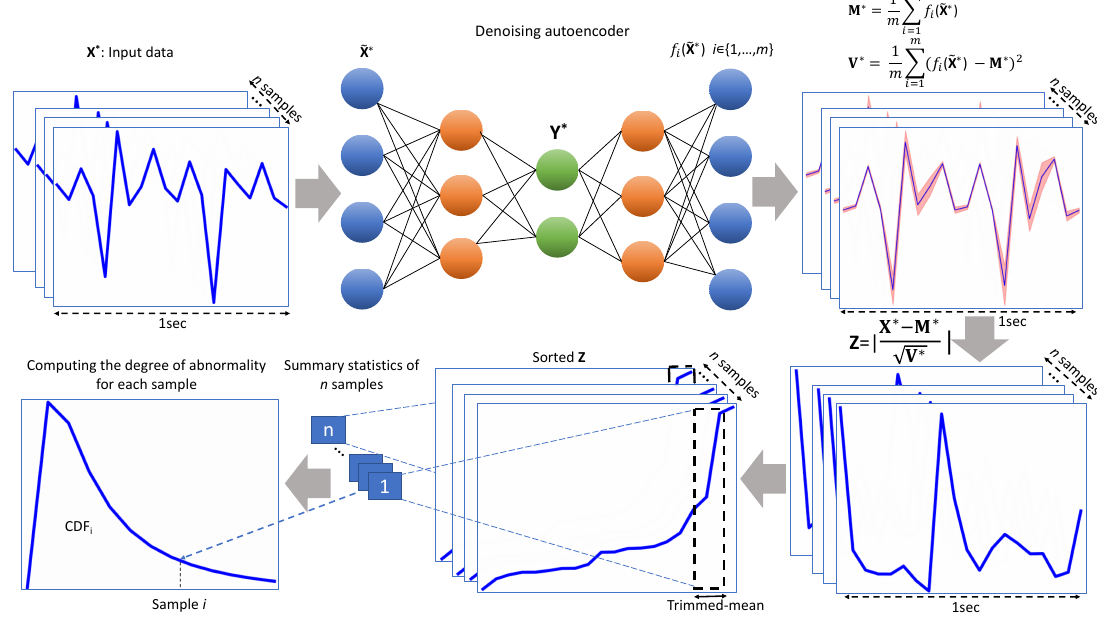
Figure 1. The proposed method for the abnormal movement detection in the test